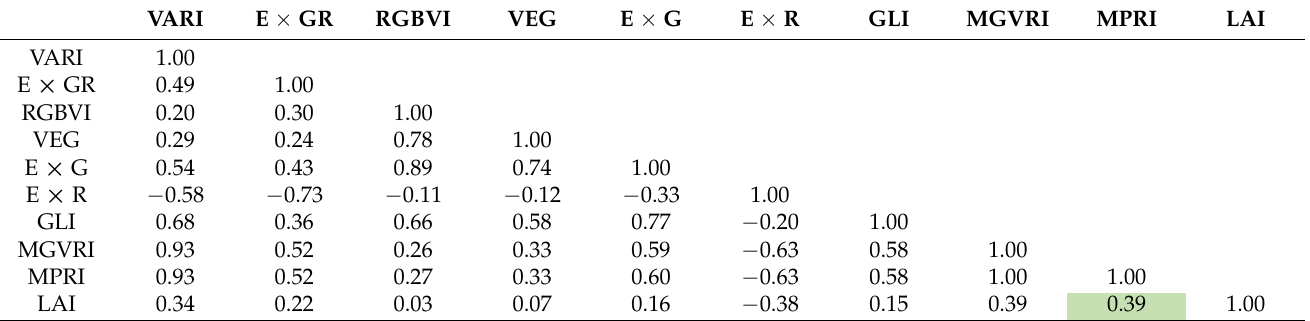
Table 4. Correlation between VIs and LAI in the fourth phase of the phenological cycle of the coffee.